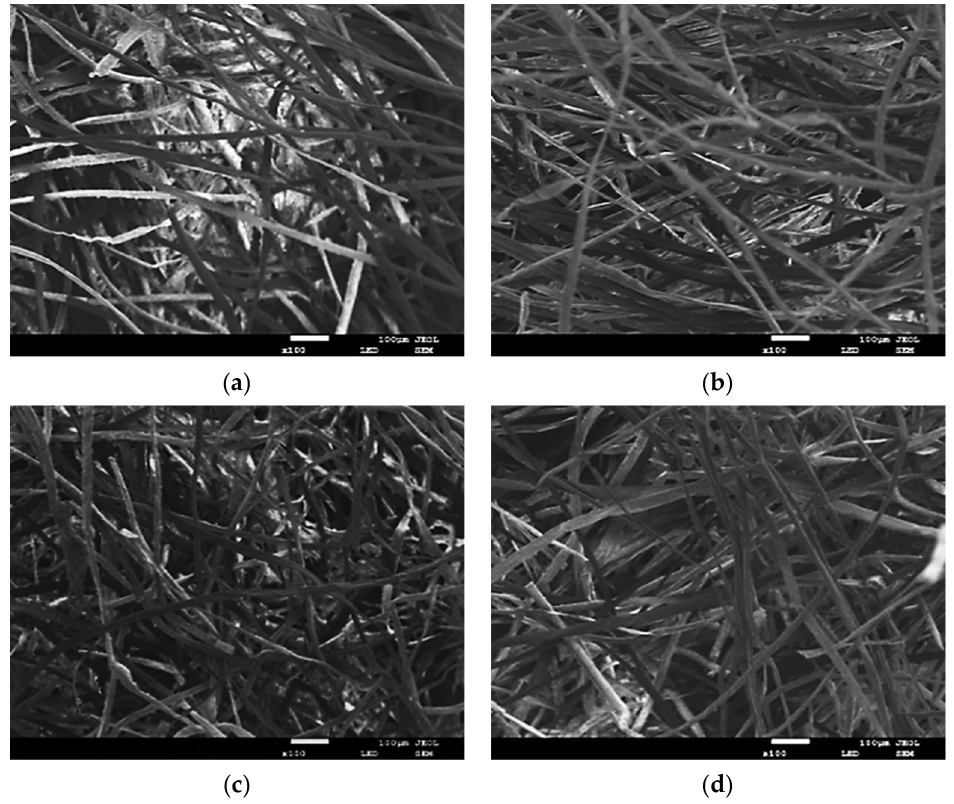
Figure 6. SEM of composite materials with different kapok fibre mass fractions. ( a ) 7# 30%; ( b ) 8# 40%; ( c ) 9# 50%; ( d ) 10# 60%. The SEM images with a thickness of 0.5, 1.0, 1.5, 2.0, 2.5, and 3.0 cm were numbered as 11#–16# in Figure 7.